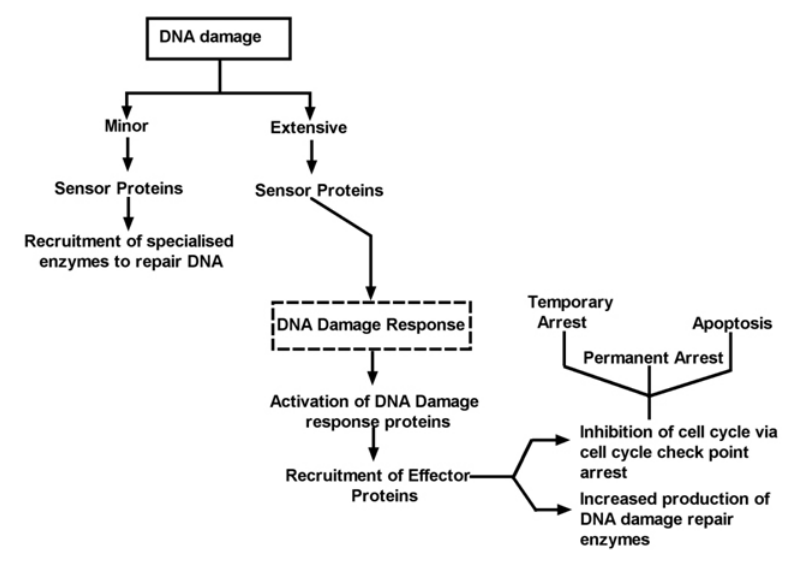
Figure 1. Cellular responses to DNA damage. Depending upon the scale of DNA damage, eukaryotic cells respond by activating specialised pathways that take decision of cell fate between DNA repair, temporary or permanent cell cycle arrest or apoptosis